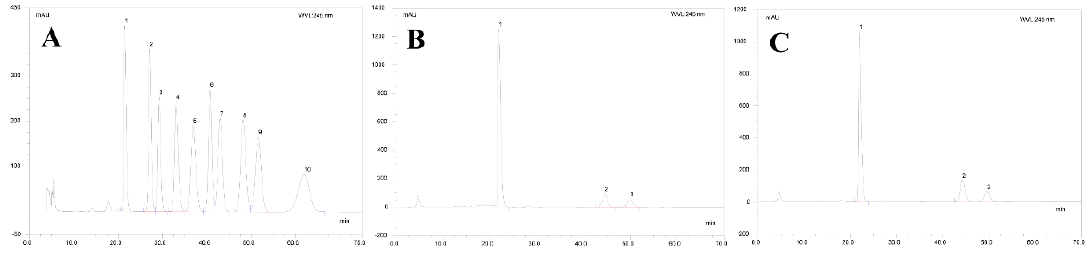
Figure 3. HPLC results of standard monosaccharides, AMEP-1 and AMEP-2: ( A ) HPLC results for standard monosaccharides (1-Man, 2-GlcN, 3-Rha, 4-GlcA, 5-GalA, 6-GalN, 7-Glc, 8-Gal, 9-Xyl, and 10-Fuc); ( B ) HPLC results of AMEP-1 monosaccharides composition (1-Man, 2-Glc, and 3-Gal); and ( C ) HPLC results of AMEP-2 monosaccharides composition (1-Man, 2-Glc, and 3-Gal).